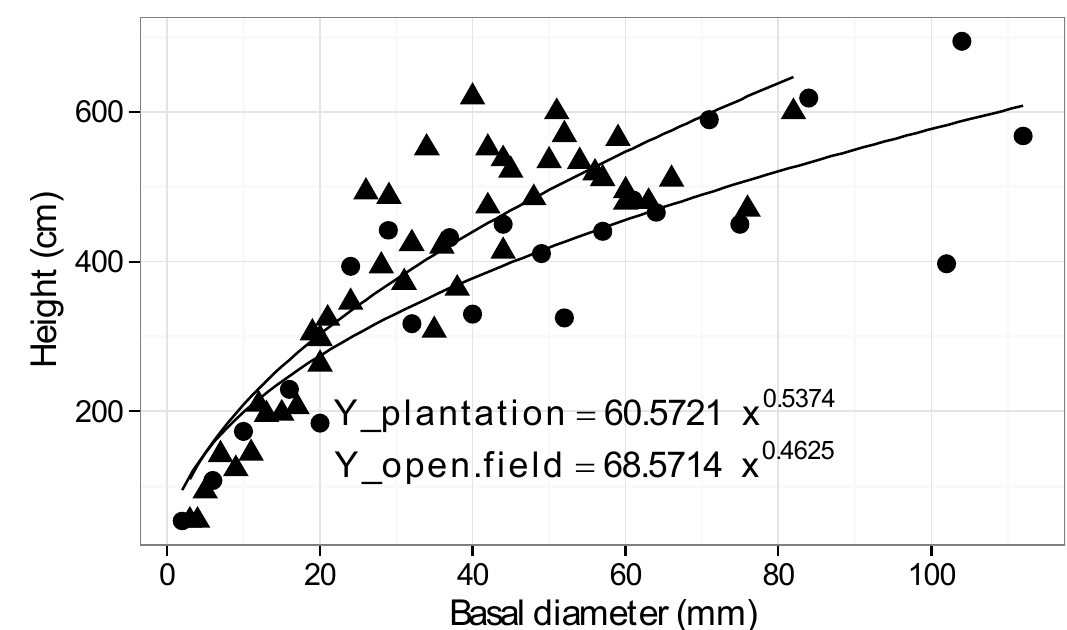
Figure 5. Environment-specific allometric relationships for glossy buckthorn between basal diameter (mm) and height (cm). Triangle symbols = Plantation data points; Circle symbols = Open